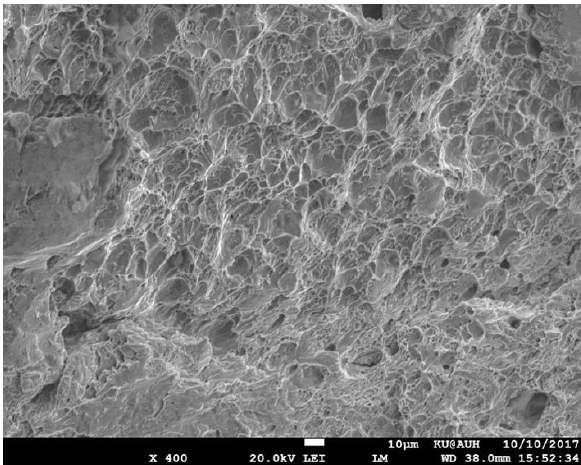
Figure 12. Dimple fracture in the “fresh” fracture region .